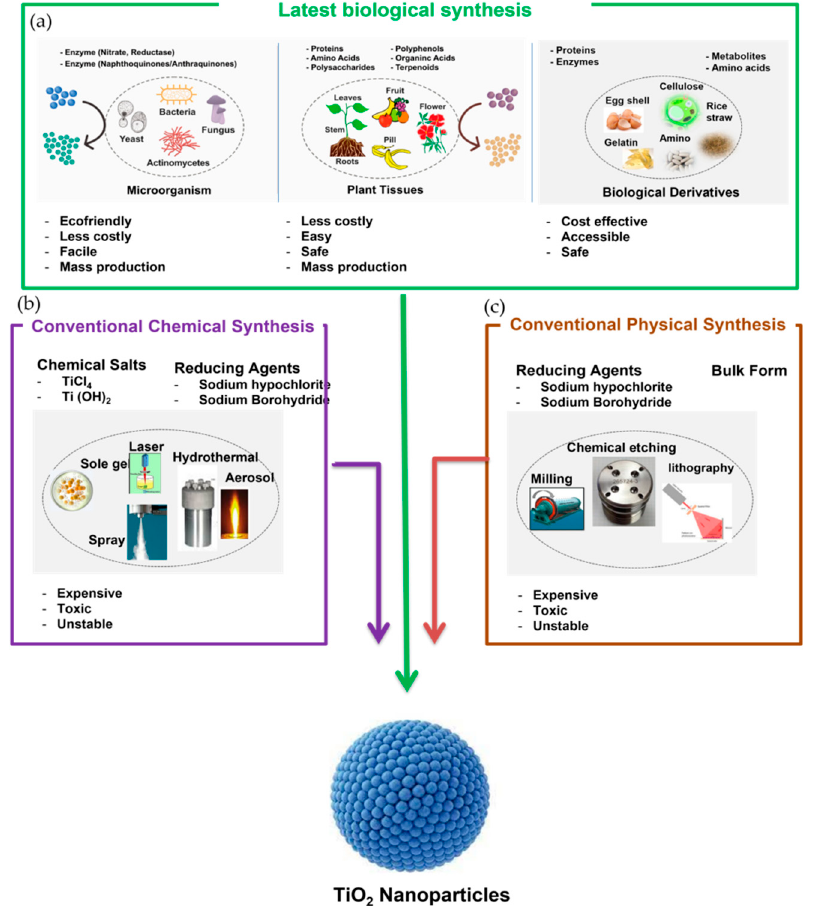
Figure 4. Role of synthesis protocols on advantages and disadvantages of conventional and biolog- ical TiO 2 NPs: ( a ) micro-organisms, plant tissues, and natural derivatives utilized by the latest bio- logical synthesis; ( b ) chemical salts and reducing agents utilized by conventional chemical synthesis; and ( c ) bulk form and reducing agents utilized by conventional physical synthesis (idea adapted from the ref) [86,87].